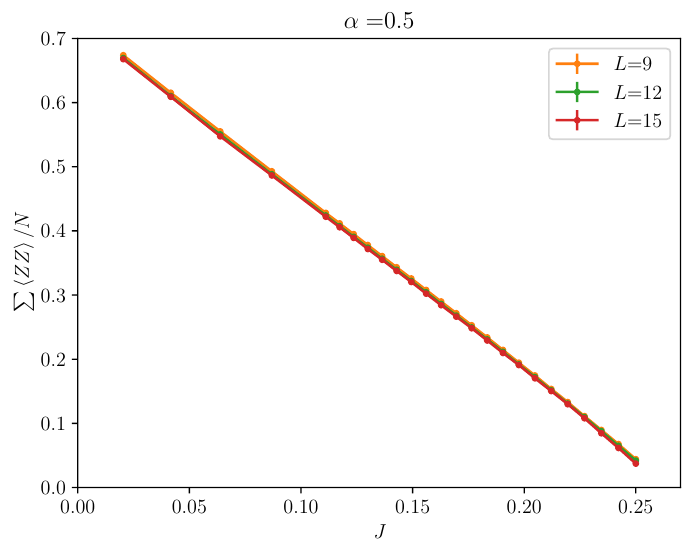
Figure 10: We observe no visible discontinuity in dE conventional first-order